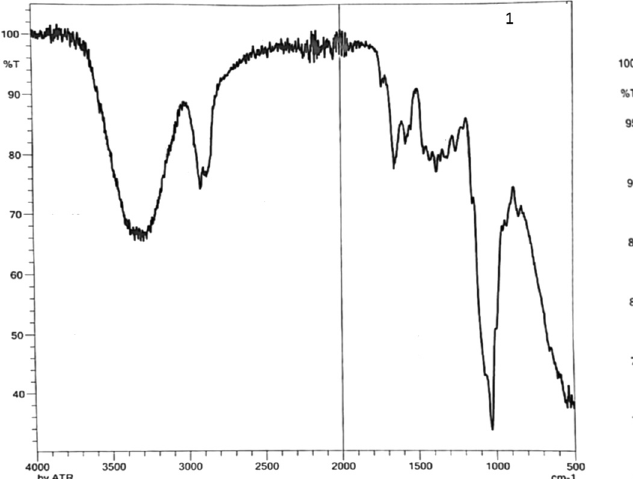
Figure A1: FTIR of fi lm 1.